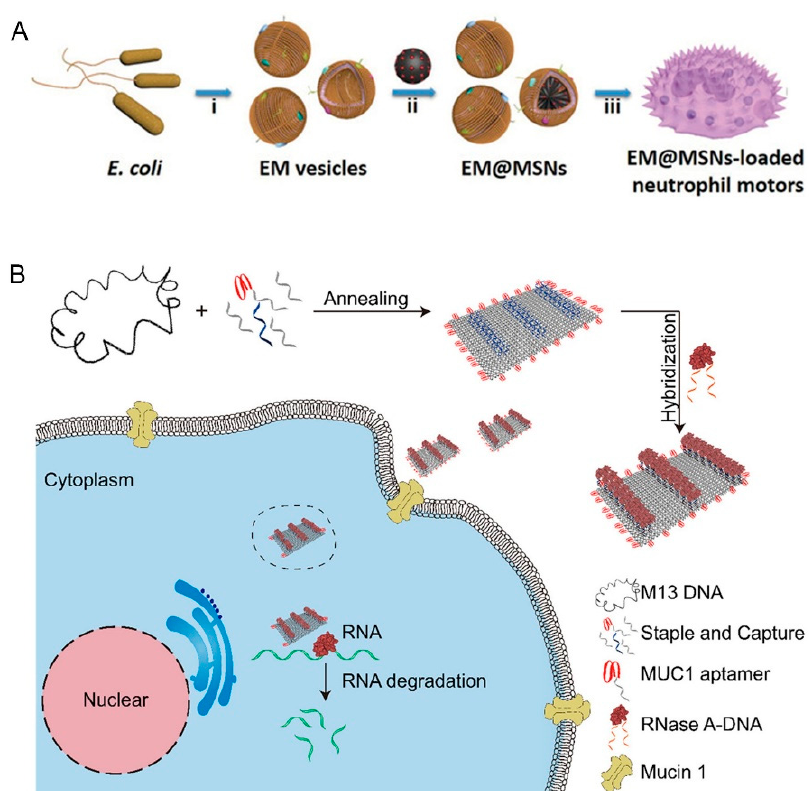
Figure 4. Other nanorobots with the enhanced targeted drug delivery ability. ( A ) Chemotaxis-guided hybrid neutrophil micromotor used for targeted drug delivery by (reprinted from [69] with permission from John Wiley and Sons, 2017). ( B ) DNA origami nanorobot used for RNase A delivery (reprinted from [78] with permission from American Chemical Society,